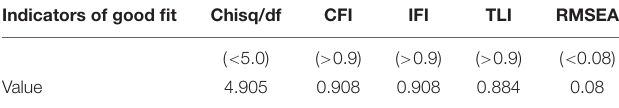
TABLE 6 | Indicators of good fit of the model to the data ( N =